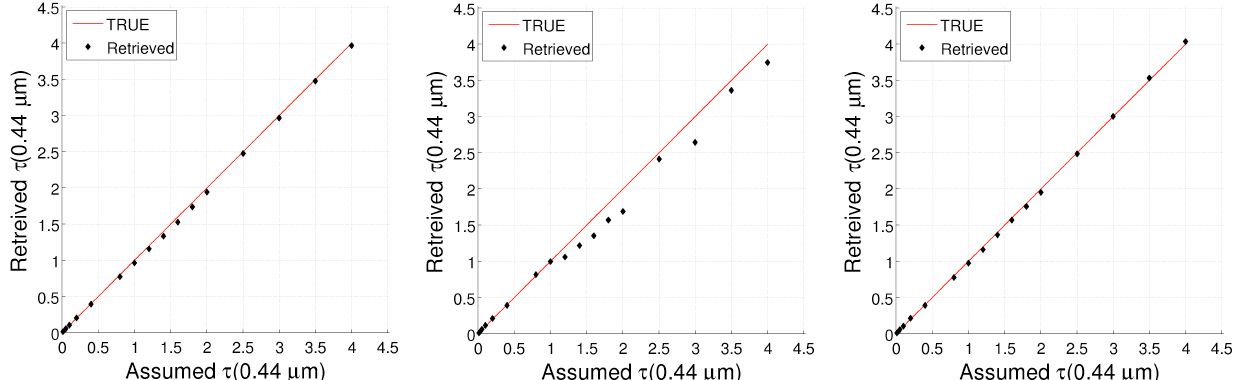
Fig. 8. Retrieval of biomass burning optical thickness over Mongu for 16 different aerosol loadings from τ (0.44µm)=0.01 to 4.0: (left panel) single-pixel retrieval with no noise added; (center panel) single-pixel retrieval with the random noise added; (right panel) multi-pixel retrieval with the random noise